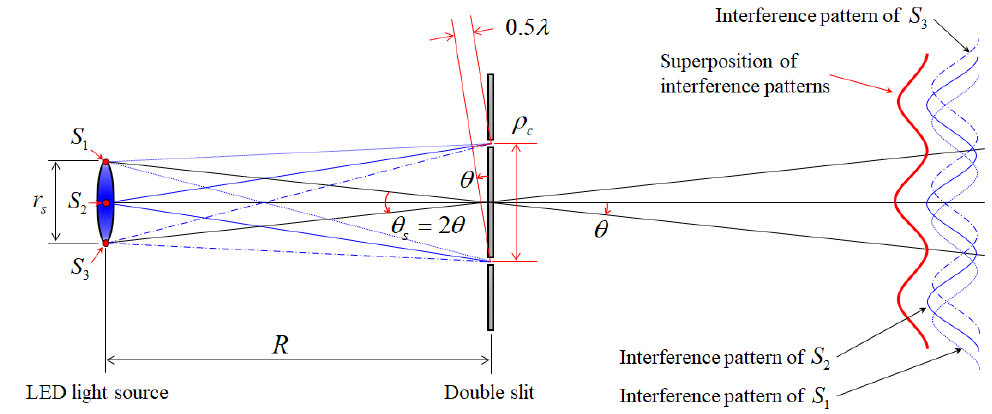
Figure 1. Relationship between the size of the light source and the spatial coherence.